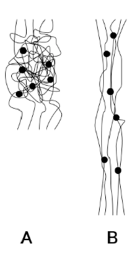
Figure 16. Elastomer structures: ( A ) is an unstressed polymer; ( B ) is the same polymer under stress.